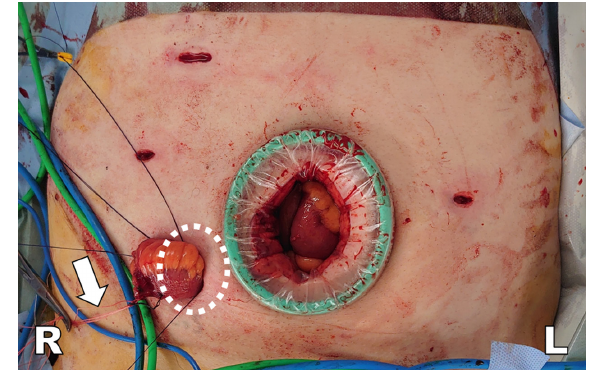
Figure 2. The distal end of the harvested ileum was pulled out of the abdominal wall through a small incision in the skin (stoma site, circle with white broken lines). After irrigating the ileum with saline, silk sutures were tied to the intestinal mucosa of the ileum (white arrow).